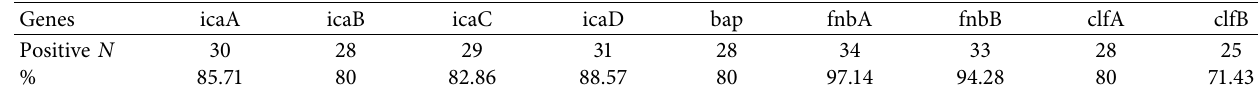
Table 7: Genotypic evaluation of biofilm production in S. aureus strains isolated from row cow milk.